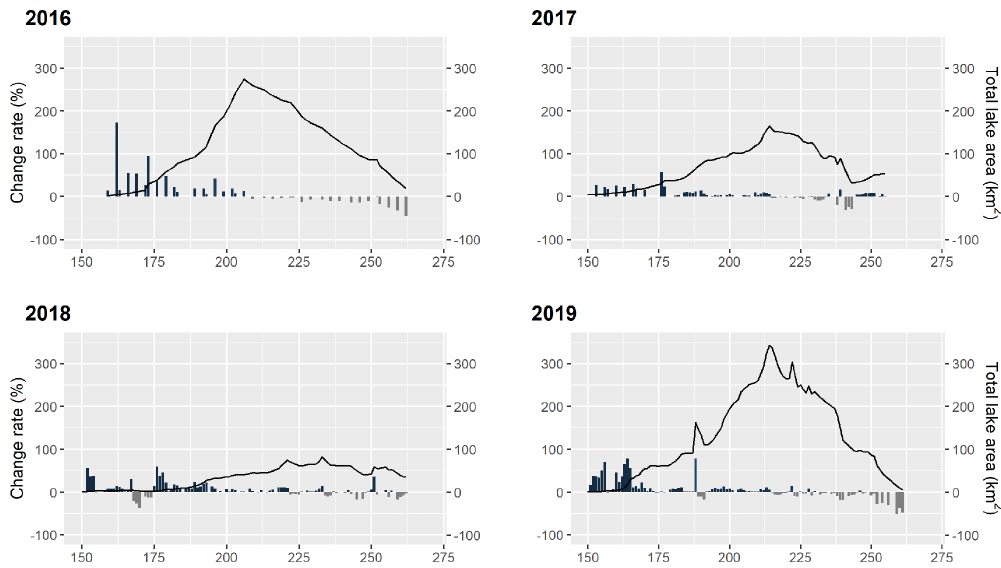
Figure 2. Change rates of the lake area between observations from 2016 to 2019, limited to DOY 150–270 (bars, in percent of the last observed area). Line graph: total lake area in km 2